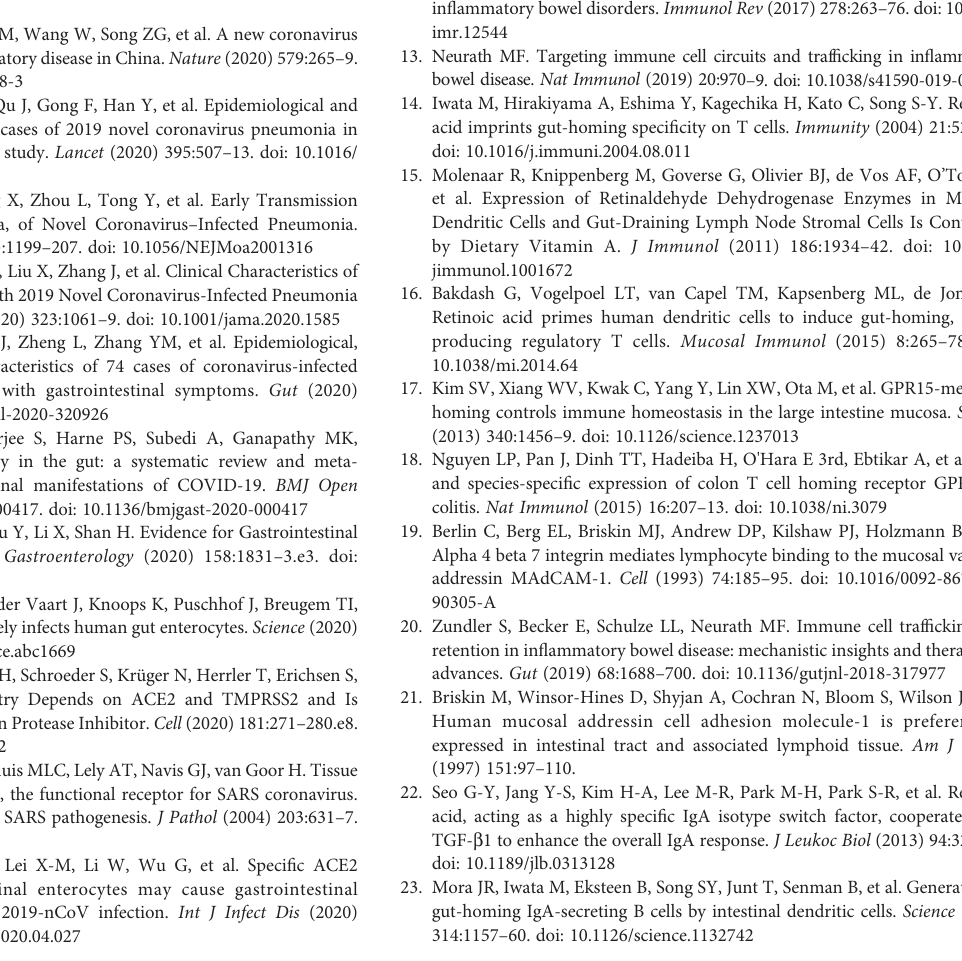
Supplementary Figure 1 | Lymphocyte subsets in PBMCs from COVID-19 and recovered patients compared to healthy controls. Representative (left) and quantitative (right) fl ow cytometry of the frequency of CD3 + (A) and CD3 + CD4 + (B) T cells among lymphoid cells selected based on forward and sideward scatter,